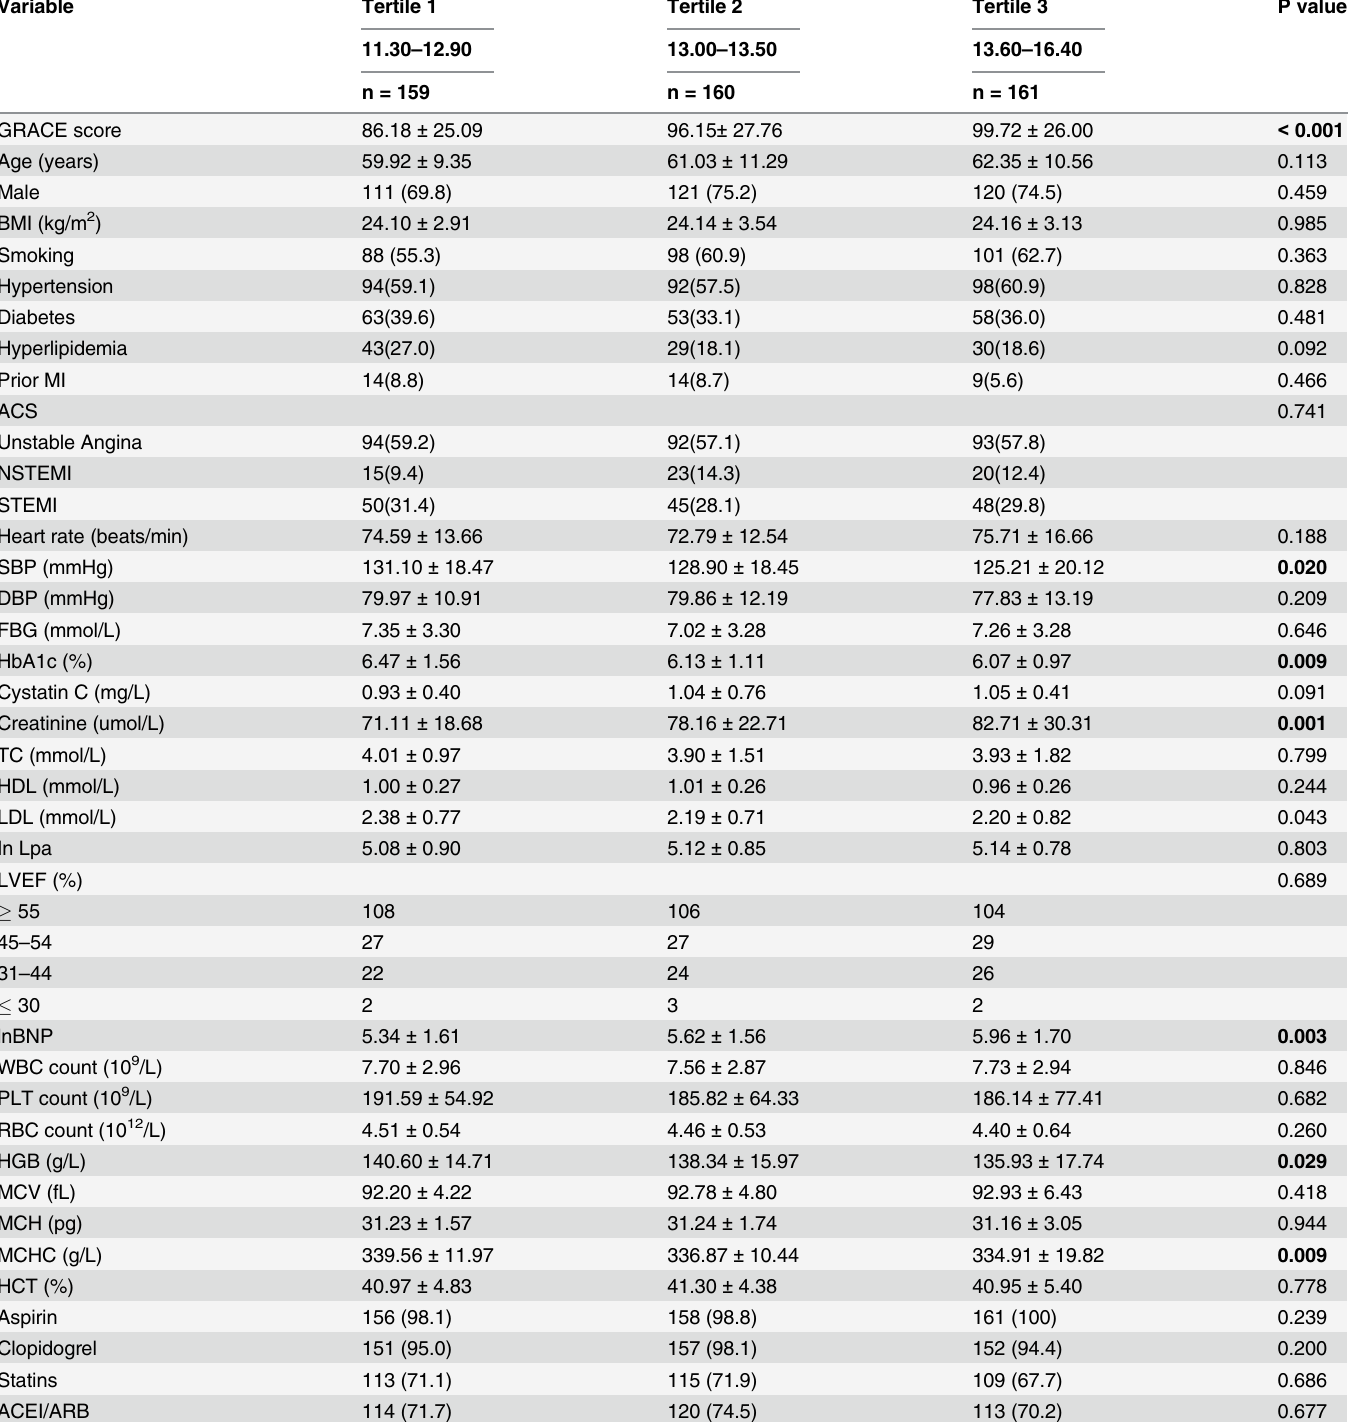
Table 1. Baseline characteristics of 480 patients with acute coronary syndrome (ACS) undergoing percutaneous coronary intervention (PCI) according to the RDW content